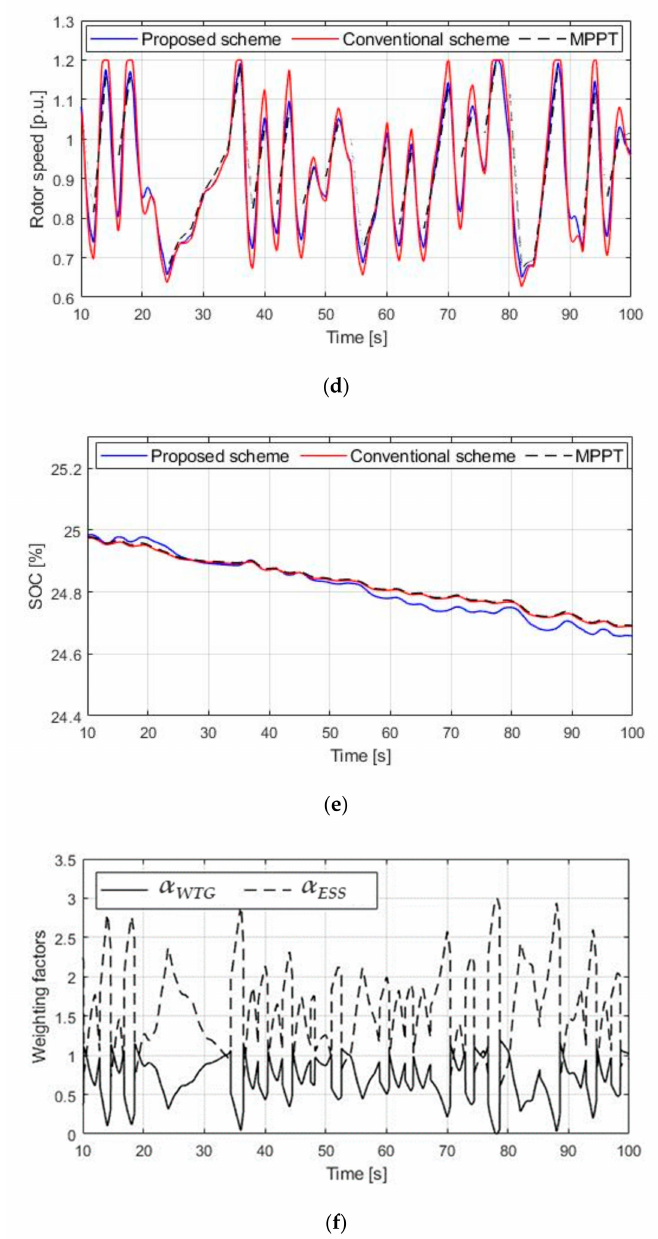
Figure 10. Simulation results for case 2: ( a ) system frequencies, ( b ) active powers of the WTG, ( c ) active powers of the ESS, ( d ) rotor speeds of the WTG, ( e ) SOCs of the ESS, and ( f ) weighting factors of the coordinated